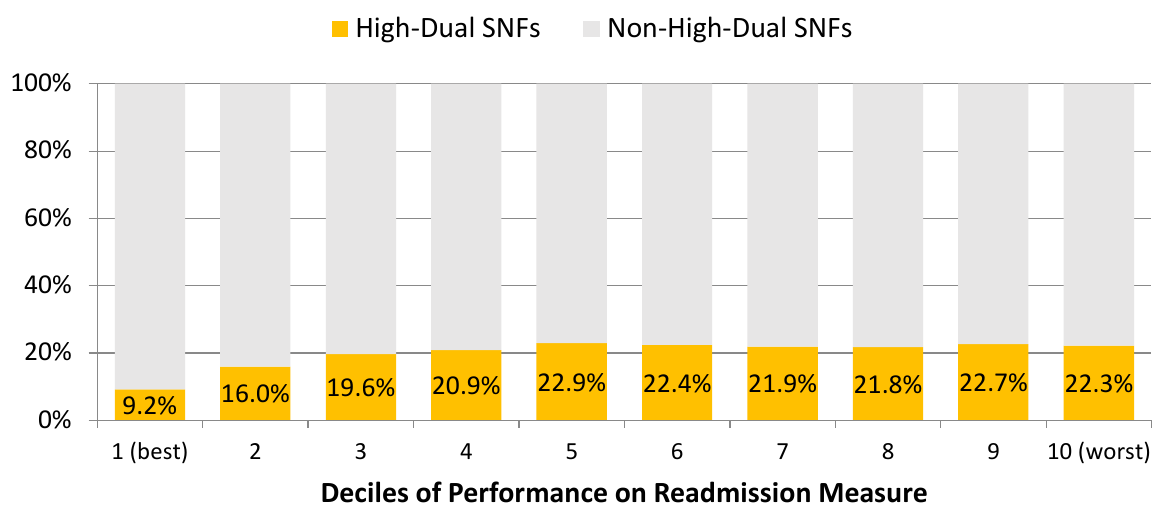
However, there were high-dual SNFs represented in every decile of performance, including the best performing